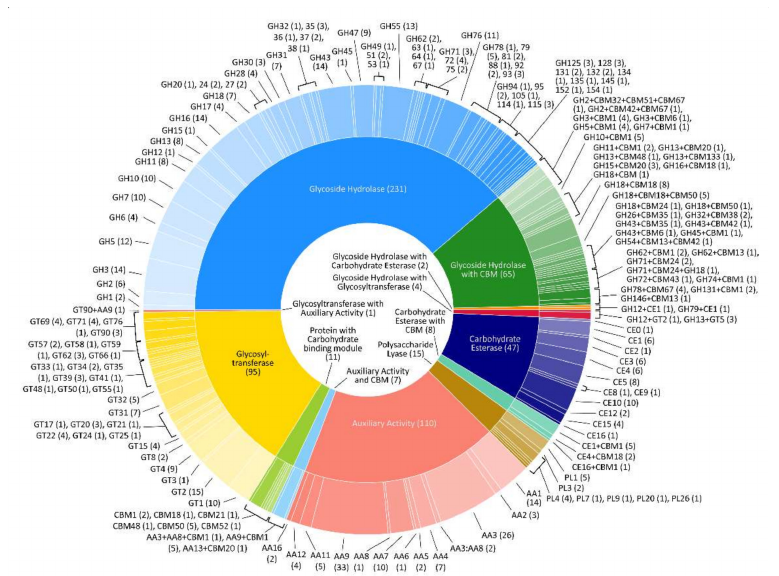
Figure 3. Representation of CAZymes encoded by the S. longicolleum genome following the analysis of coding regions revealed by de novo sequencing. The inner ring represents the enzyme classes, and the outer ring names the families. Numbers in brackets represent the frequency of occurrence, also coded by size. Families matching more than one CAZyme category are depicted by strings of